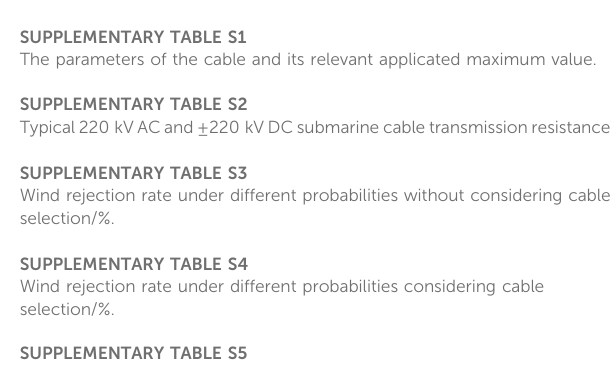
SUPPLEMENTARY TABLE S3 Wind rejection rate under different probabilities without considering cable selection/%. SUPPLEMENTARY TABLE S4 Wind rejection rate under different probabilities considering cable selection/%. SUPPLEMENTARY TABLE S5 Cable parameters with technical